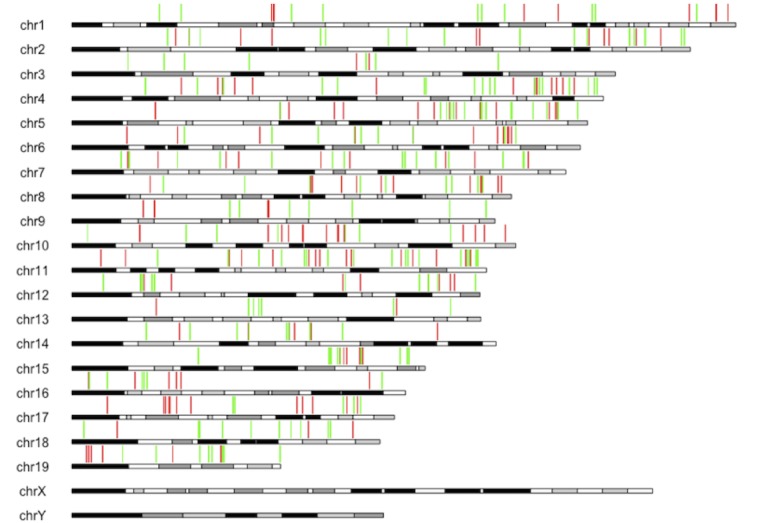
Distribution of WLMT clock CpG sites along the mouse genome.Sites with positive weights (increasing methylation with age) are shown in green, and those with negative weights (decreasing methylation with age) in red.